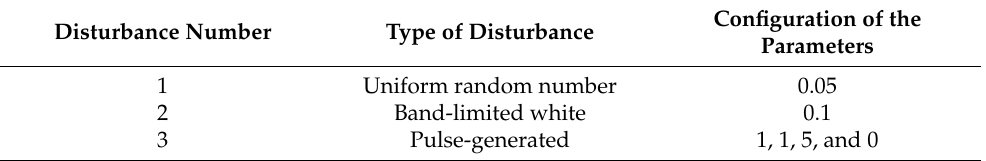
Table 3. Types of disturbances applied to the controller.